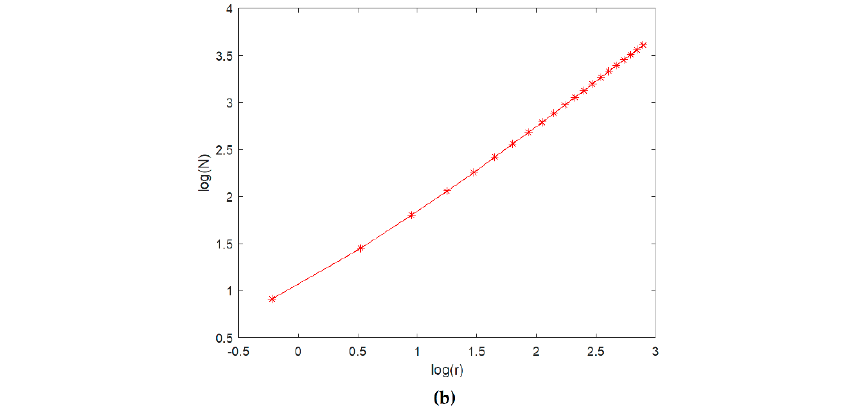
Figure 5. ( a ) An instant of a time segment (QT) of normal and early CAN signal; ( b ) log N vs. log r for a normal signal for FD computation.